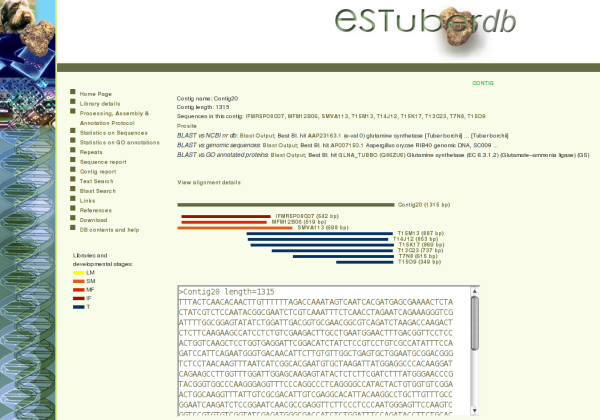
The ESTuber db contig page. A detailed page for each contig is included in the database, where a graphical display, the contig consensus sequence and the contig alignment are given, together with any other supplementary information.